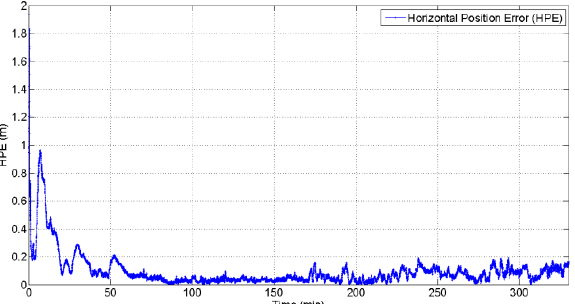
Figure 3. The HPE estimated from the difference between the real-time IGS-RTS PPP-based GPS solution and RTK-based GPS